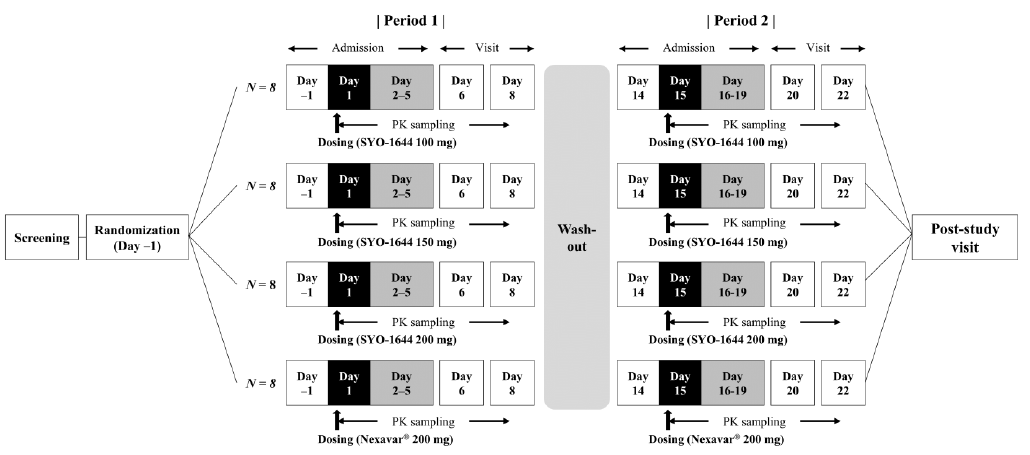
Figure 1. Study scheme.